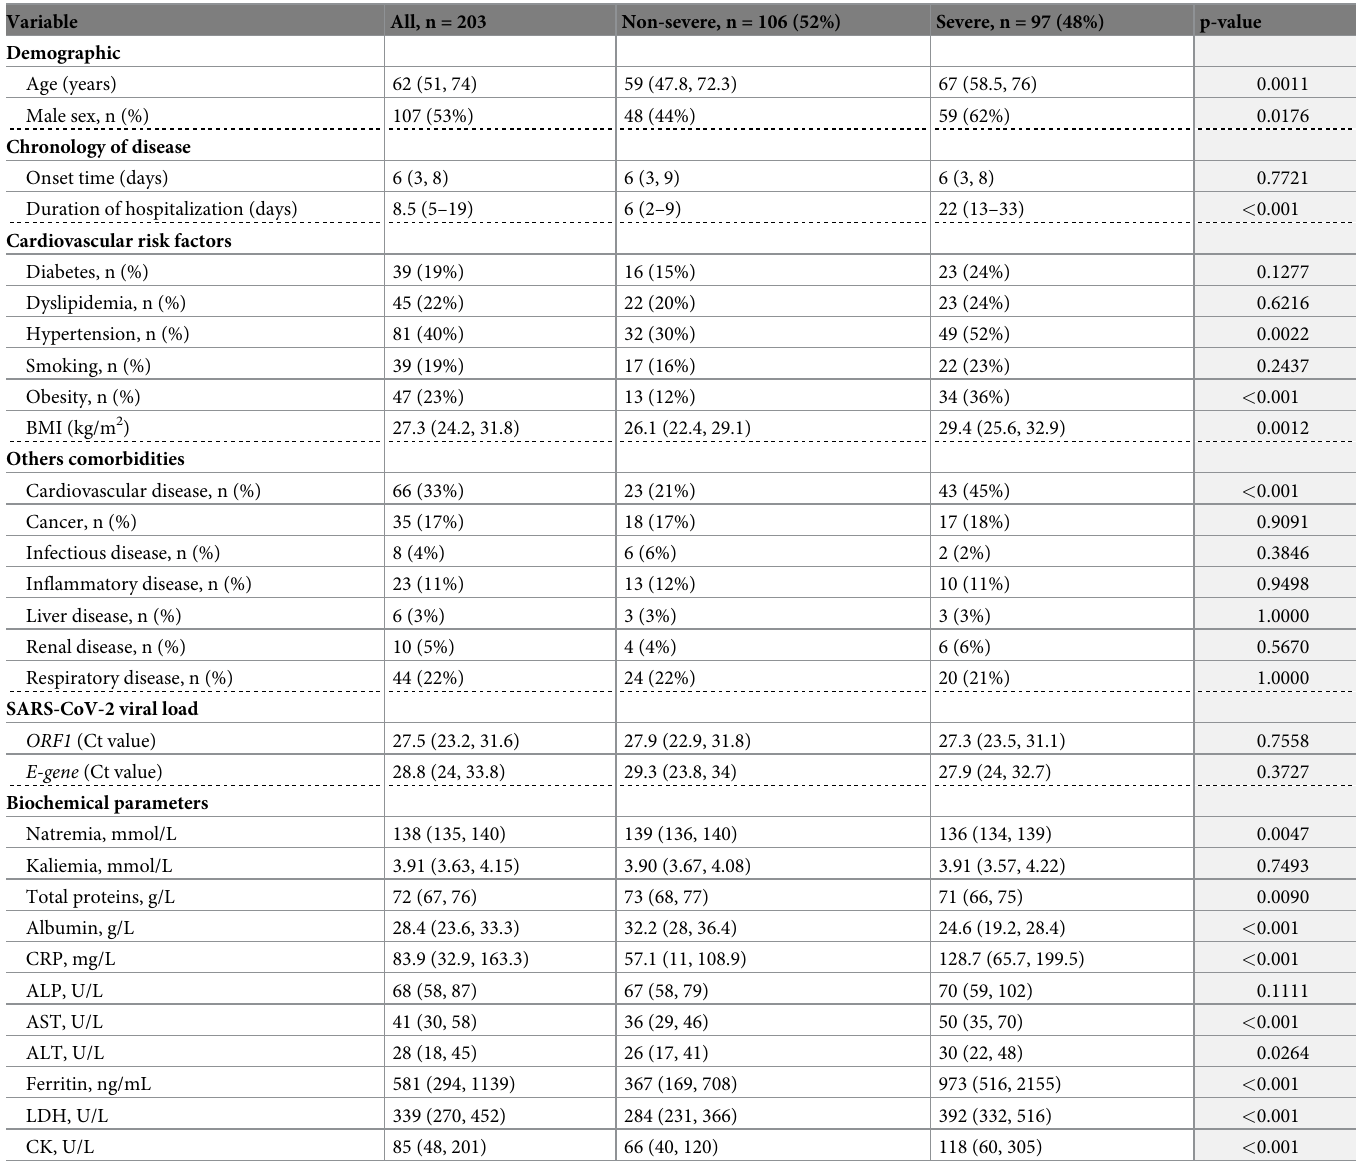
Table 1. Baseline characteristics of the COVID-19 patient